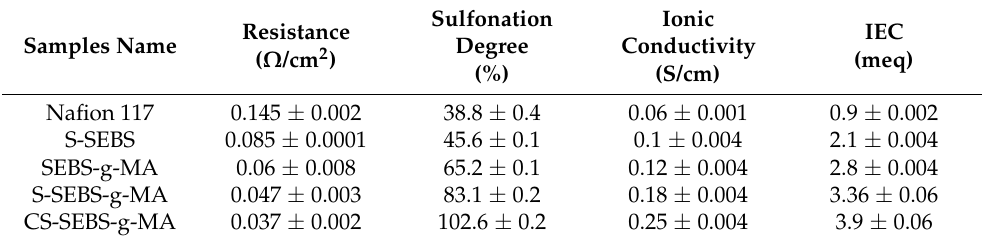
Table 2. Degree of sulfonation, ionic conductivity and IEC values obtained for the bare and modified membranes at room